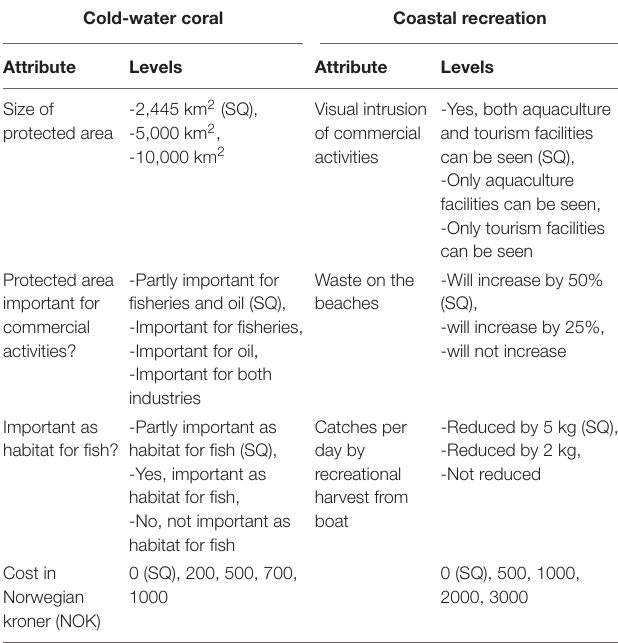
TABLE 2 | Attributes and attribute levels in the two choice experiments (SQ is status quo